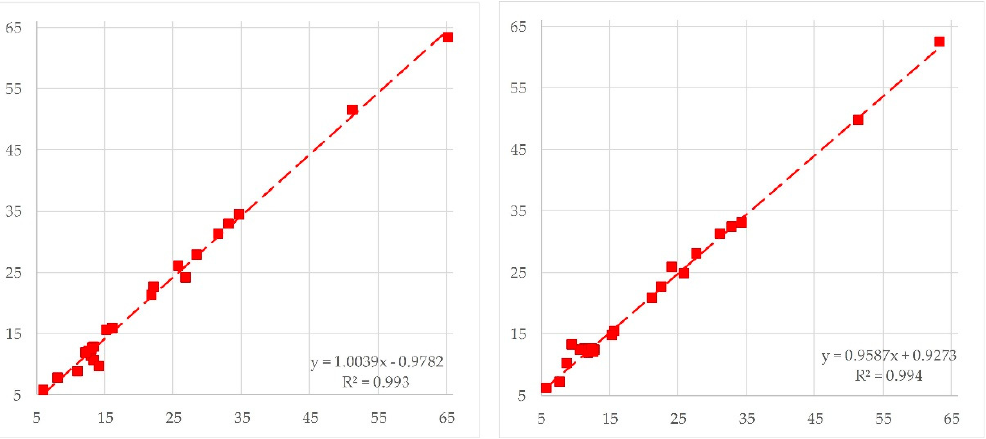
Figure 12. Correlation between actual and estimated buildings’ heights from; left—mean pixel values; right—mean vertex values.